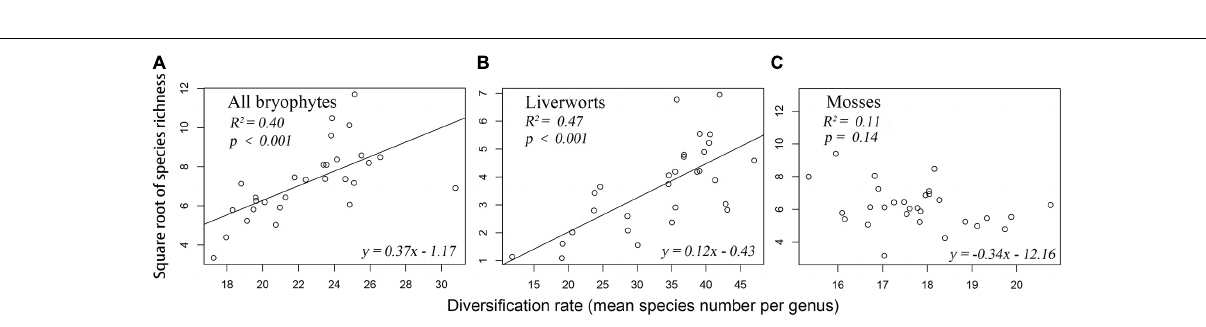
Frontiers in Ecology and Evolution |